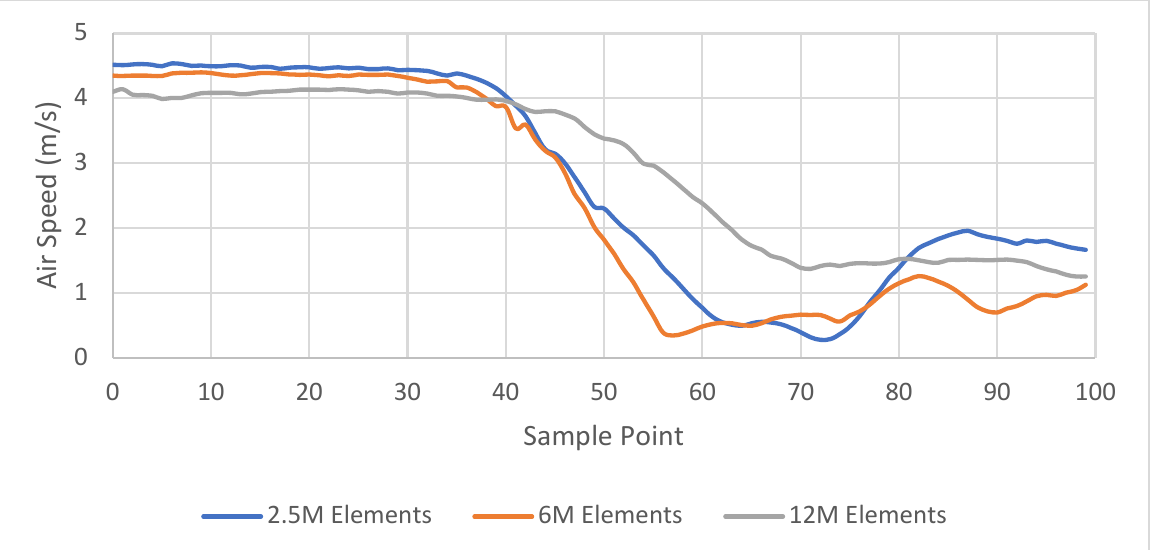
Figure 8. Mesh sensitivity analysis performed for the experimental model using a fine, medium, and coarse mesh containing 12, 6 and 2.5 million elements, respectively. The parameter measured for analysis is air speed sampled in a line underneath the rack in the direction of inlet flow.